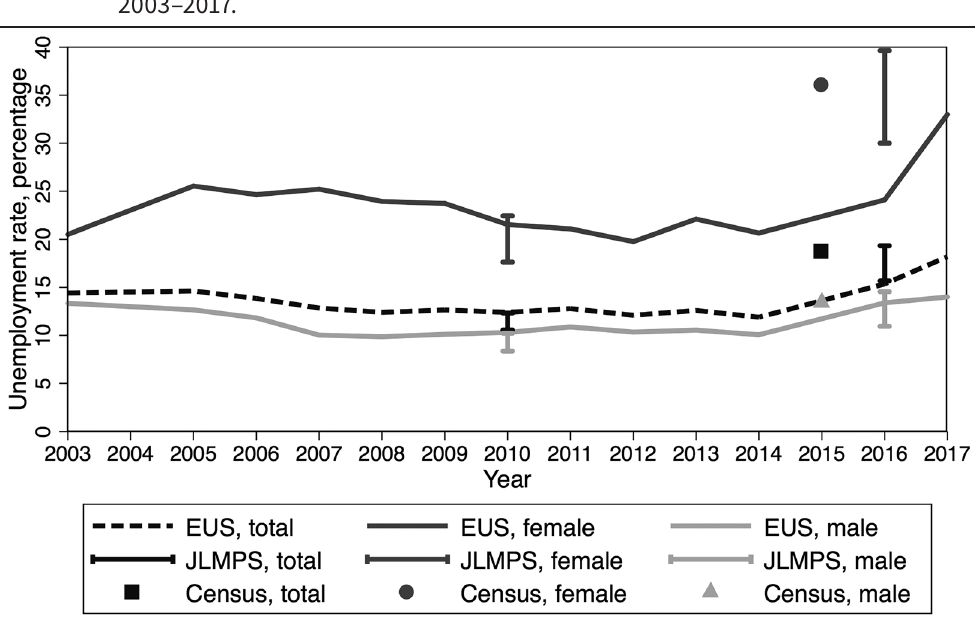
Unemployment rates (percentage) by sex and data source, Jordanians,